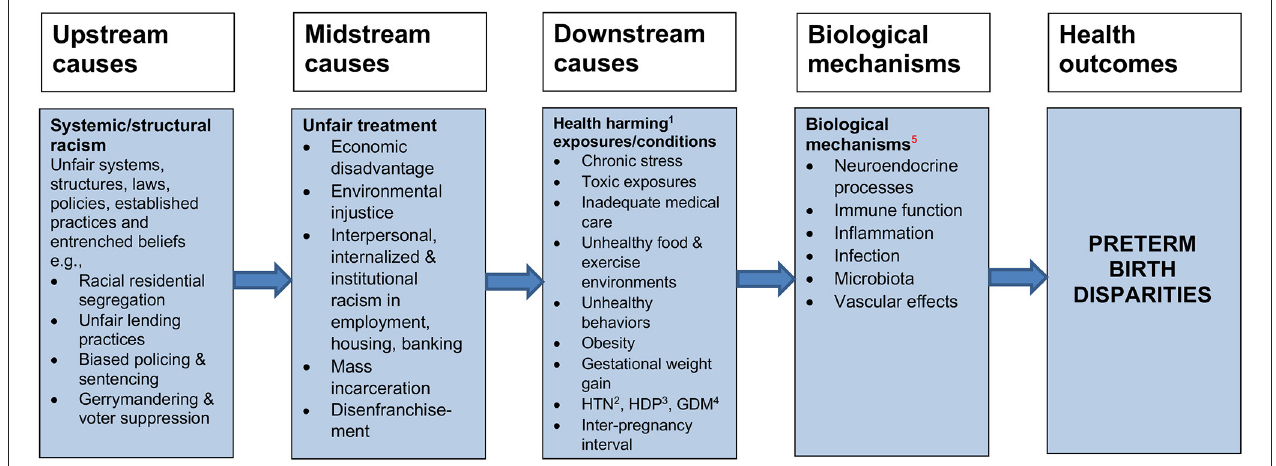
FIGURE 2 | Racism plausibly may affect PTB as an upstream factor, acting through midstream and downstream factors that more directly trigger the physiologic mechanisms. 1. Health harming or lack of health-promoting exposures/conditions. 2. HTN: Hypertension. 3. HDP: Hypertensive disorders of pregnancy. 4. GDM: Gestational diabetes mellitus. 5. Epigenetic effects are not displayed because they may occur through exposures at each step along the causal